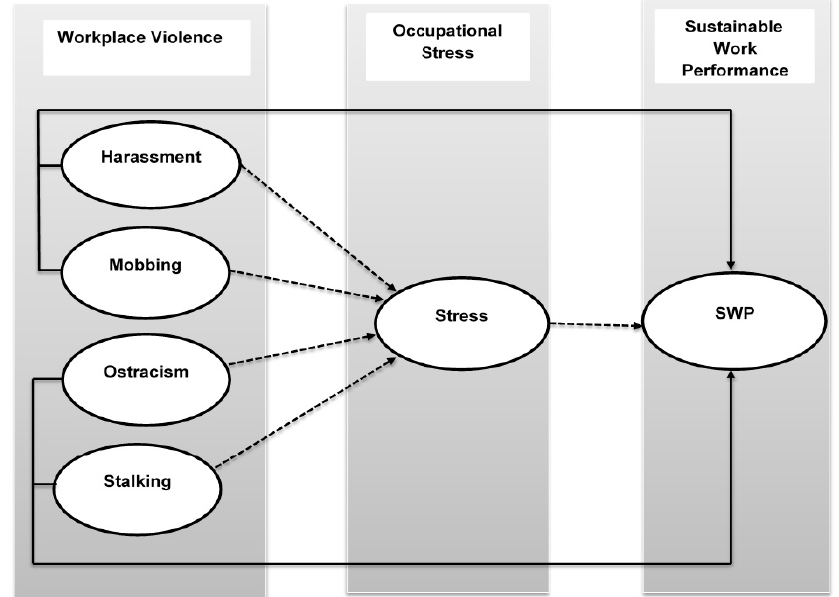
Figure 1. Conceptual model. Arrows indicate negative relationships, dashed arrows indicate indirect relationships, and solid arrows indicate direct relationships. SWP, sustainable work performance.